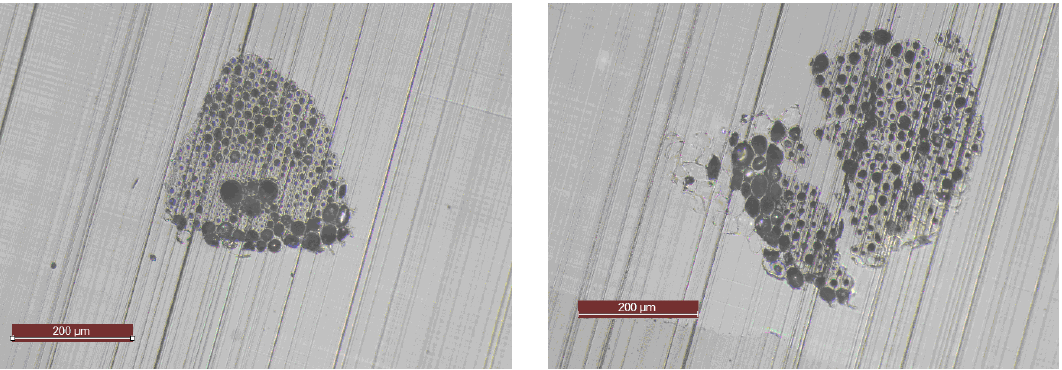
Figure 1. Cross-section of two bamboo fibers randomly extracted from the batch used in the study and imaged by optical microscopy.